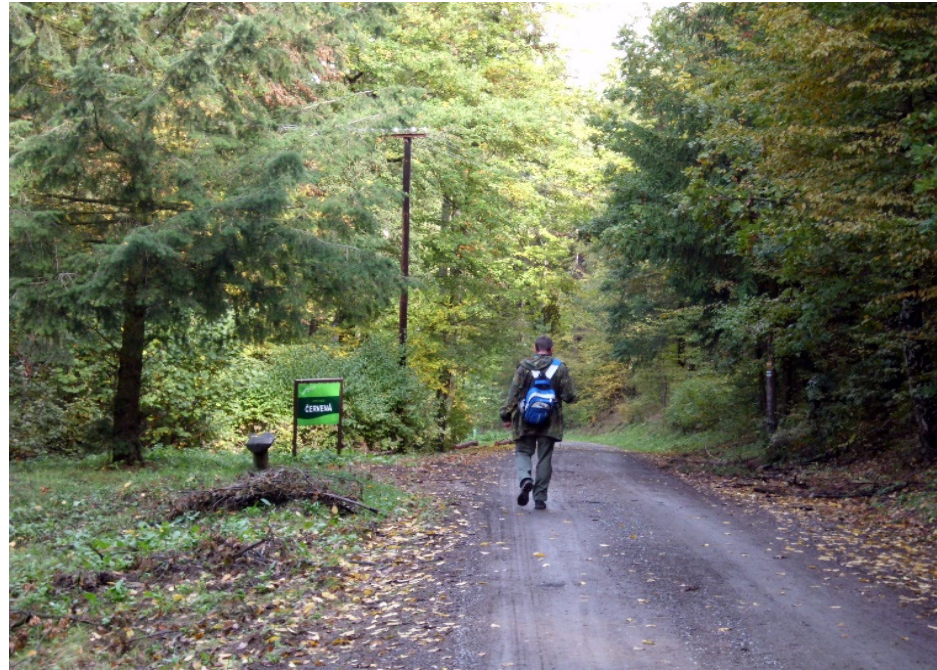
Figure 2. Training Forest Enterprise (TFE) Masaryk Forest K ř tiny (forest road “ Č ervená”) (photo by: Jitka Fialová, 15 September 2017).